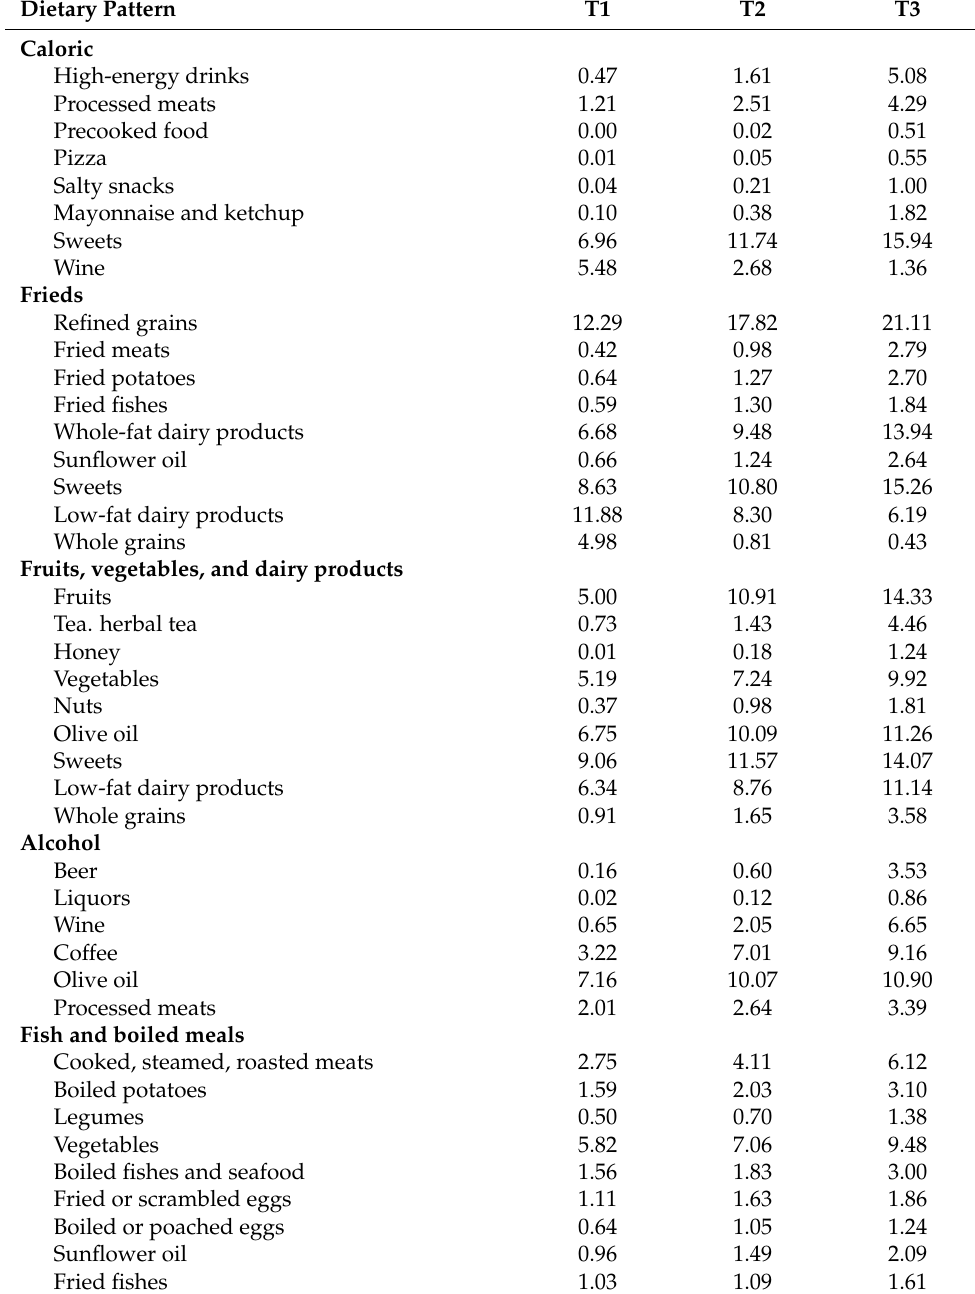
Table 4. Weekly intake of food items by tertiles of dietary patterns at